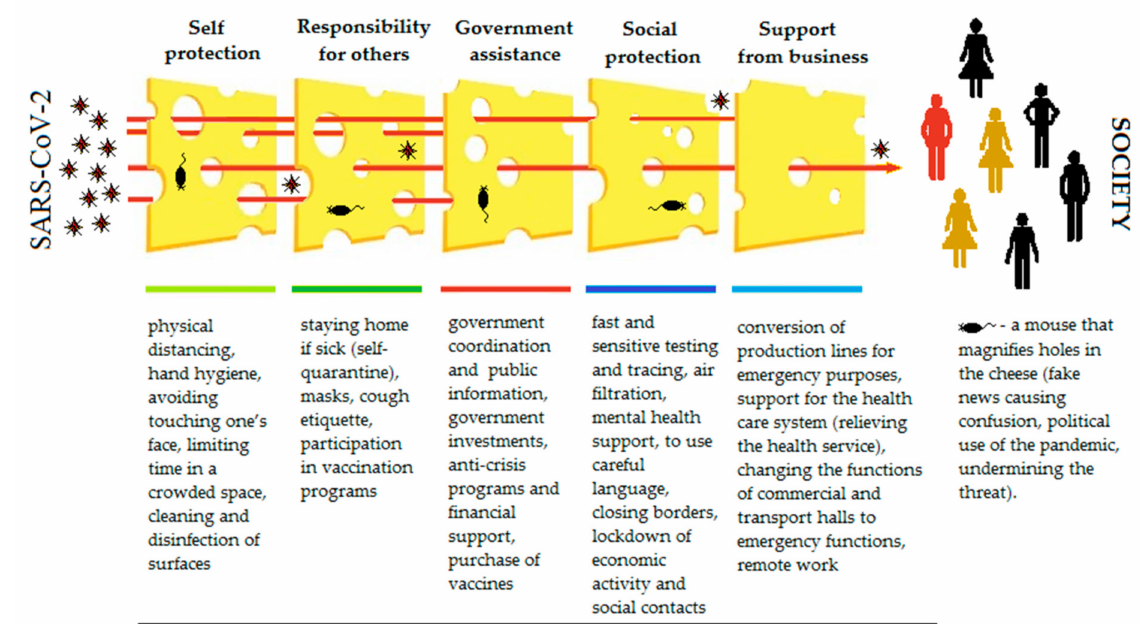
Figure 3. Multi-dimensional social open innovation model to defend against the pandemic—The Swiss Cheese Model of epidemiological protection. Source: Own